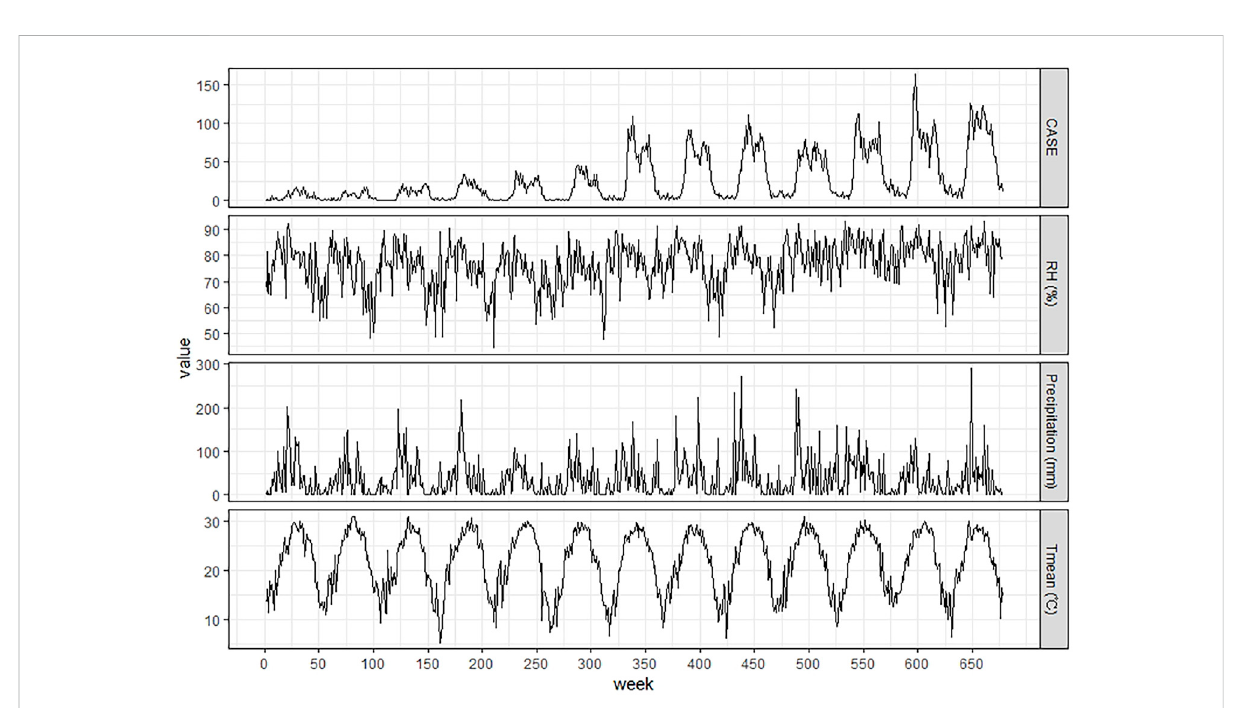
FIGURE 2 Weekly time-series distributions of ST cases and meteorological variables in Central Guangdong Province in China, 2006 –